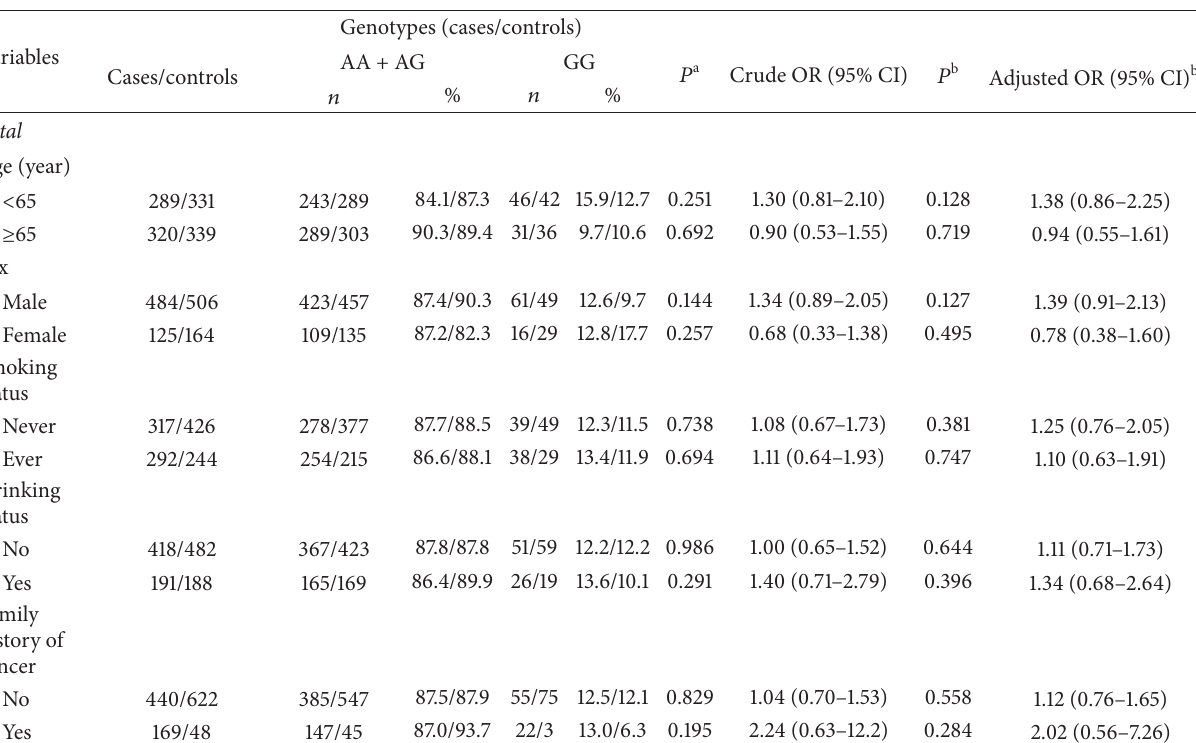
Table 3: Stratification analyses between TSP-1 -1223 A/G polymorphism and risk of bladder cancer. Genotypes Variables